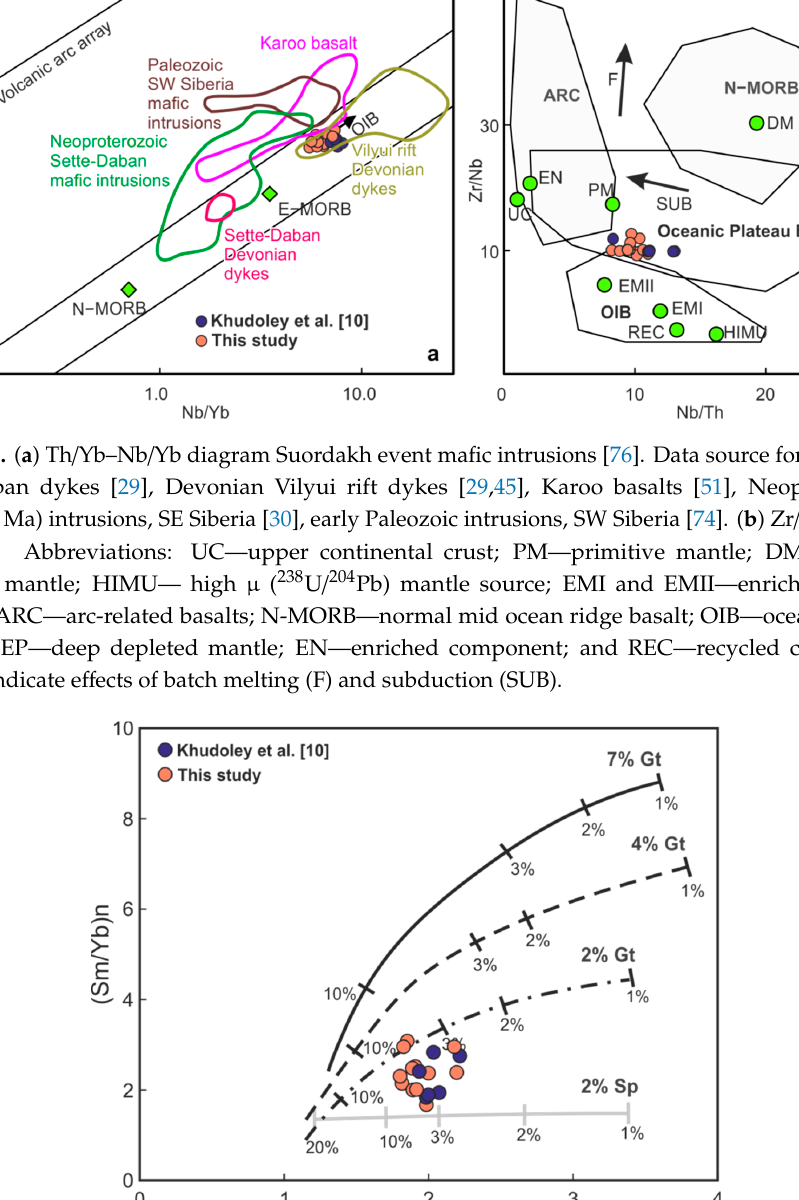
Figure 16. (Sm/Yb)n vs. (La/Sm)n diagram for the Suordakh event mafic intrusions and non-modal batch melting modeling of a lherzolitic mantle source [51]. The tick marks on the curves correspond to the melting degrees. The grey curve is the melting curve of a spinel-bearing lherzolite source, with the following modal composition: 55% olivine, 15% orthopyroxene, 28% clinopyroxene, and 2% spinel. Black curves are the melting curves of garnet-bearing lherzolite mantle sources containing 2% (dashed and dotted), 4% (dashed), and 7% (solid) modal garnet, respectively. Source modal composition is 69–64% olivine, 20% orthopyroxene, 9% clinopyroxene, and 2–7% garnet.